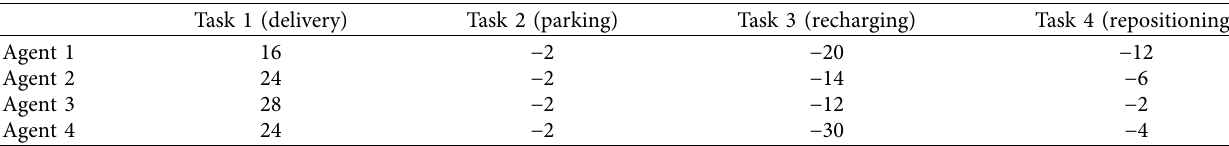
Table 6: Weighted value between 4 agents and 4 tasks (instant and single-step reward).